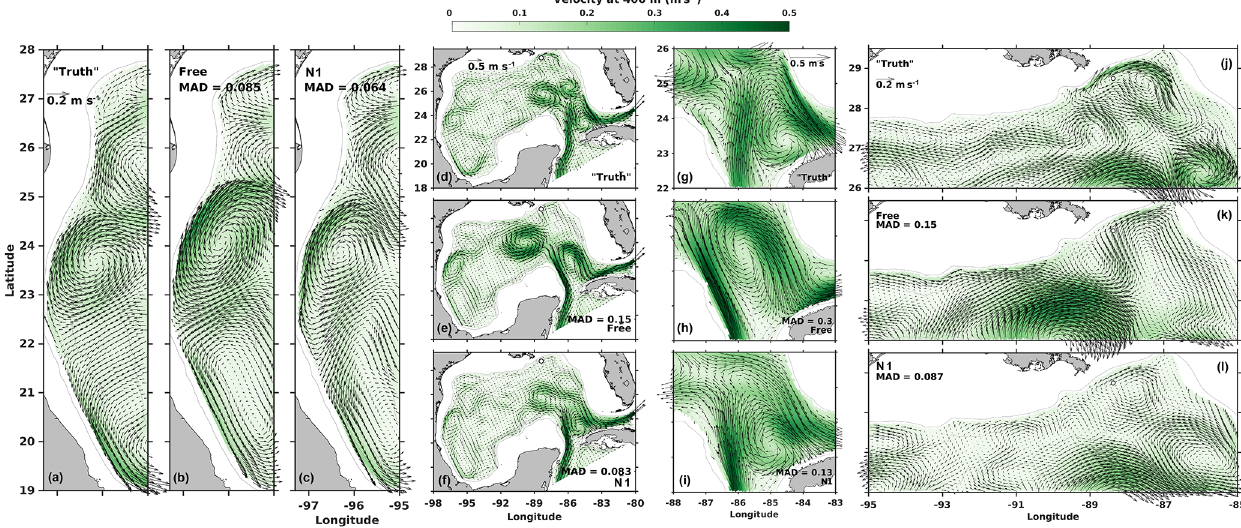
Figure 9. August mean velocity at 400m in the (a, d, g, j) “truth”, (b, e, h, k) free, and (c, f, i, l) N1 run in nonidentical twin experiments. Panels in the first, third, and fourth columns are zoomed into the western shelf, central gulf, and northern shelf, respectively. The white dot denotes the location of the DwH oil rig, and gray contours mark the bathymetric depths of 300, 1000, 2000, and 3000m, respectively.